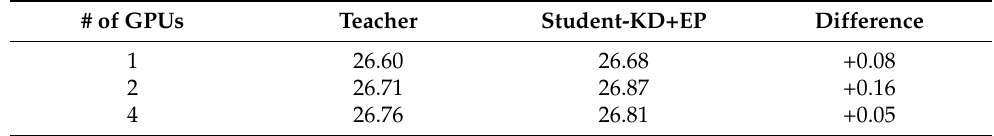
Table 9. Difference in BLEU scores between teacher and student